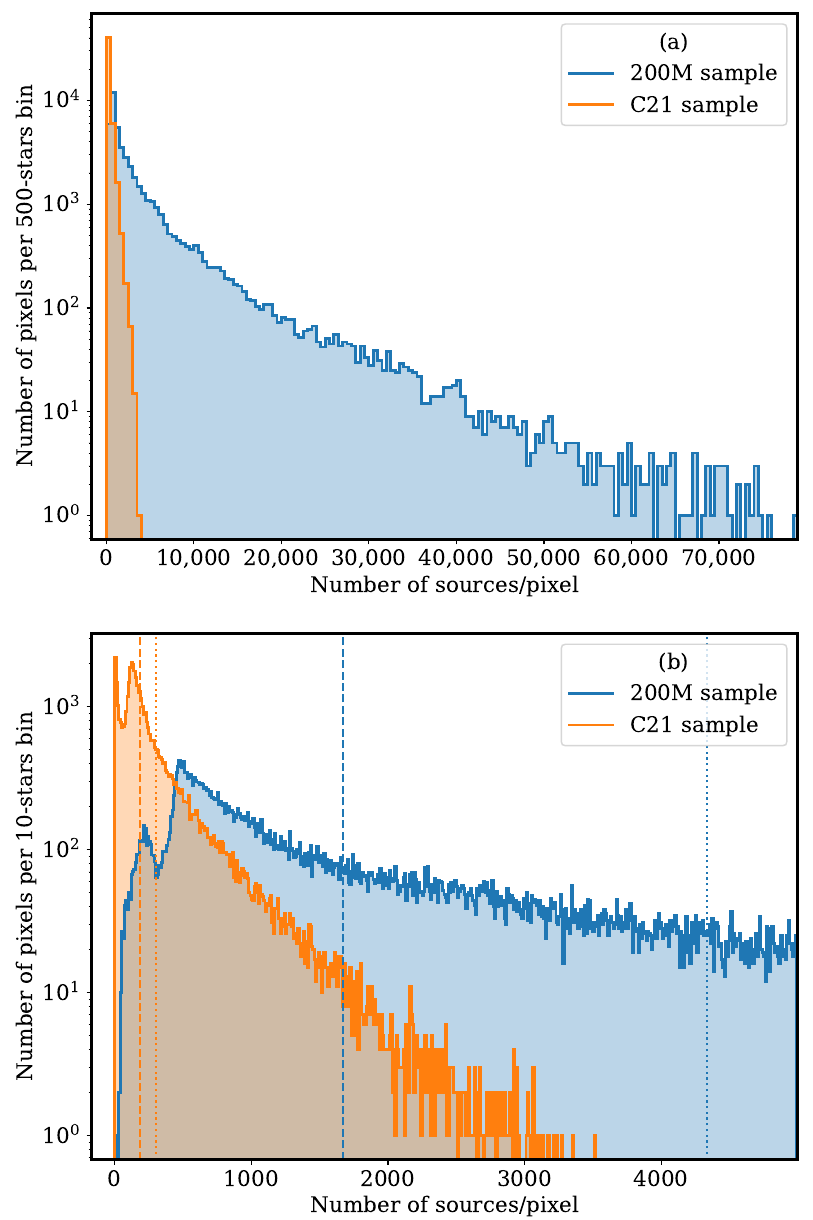
Figure 5. Panel ( a ): histograms of the source density (i.e., number of sources/pixel, where each pixel corresponds to 0.84 square degrees) in the maps displayed in Figure 4 for the 200 M sample (blue) and for the C21 sample (orange). Panel ( b ): zoom of the previous plot near the origin. The vertical lines indicate the mean values (302 and 4335 objects/pixel for C21 and 200 M, respectively; dotted lines) and median values (183 and 1668 objects/pixel for C21 and 200 M; dashed lines) for each sample. Note that a different bin size is employed in each panel as indicated in the label of the vertical